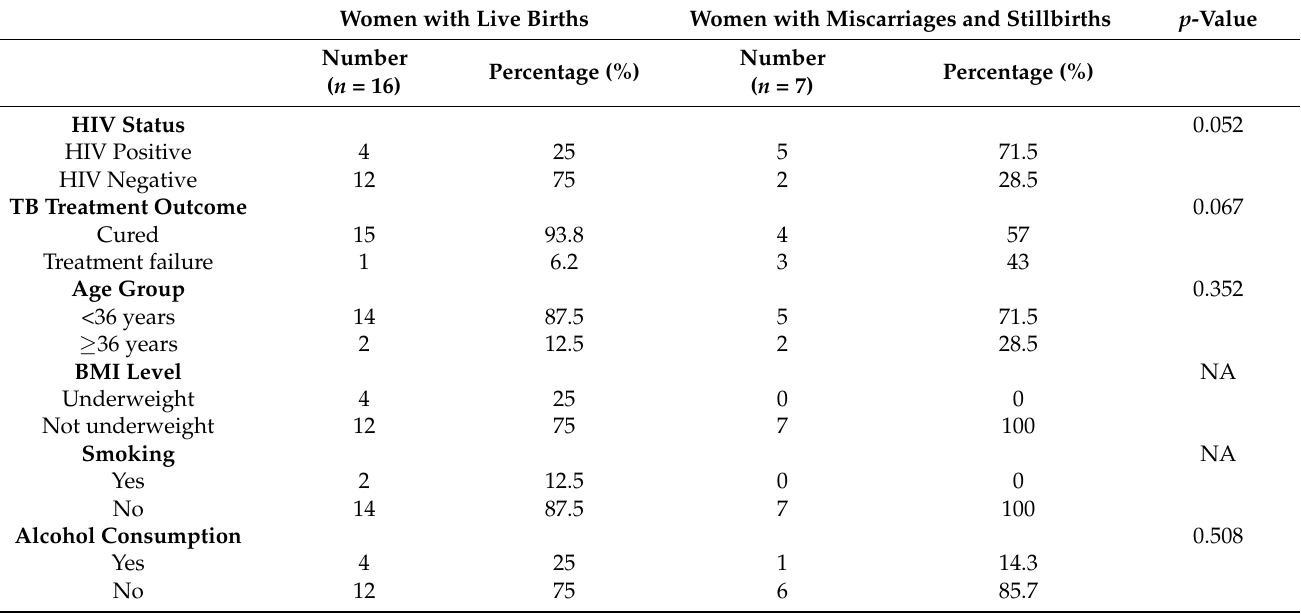
Table 2. HIV status, TB treatment outcome, age group, BMI level, smoking status, and alcohol consumption of women who had live births vs. women who had miscarriages and stillbirths. Women with Live Births Women with Miscarriages and Stillbirths p